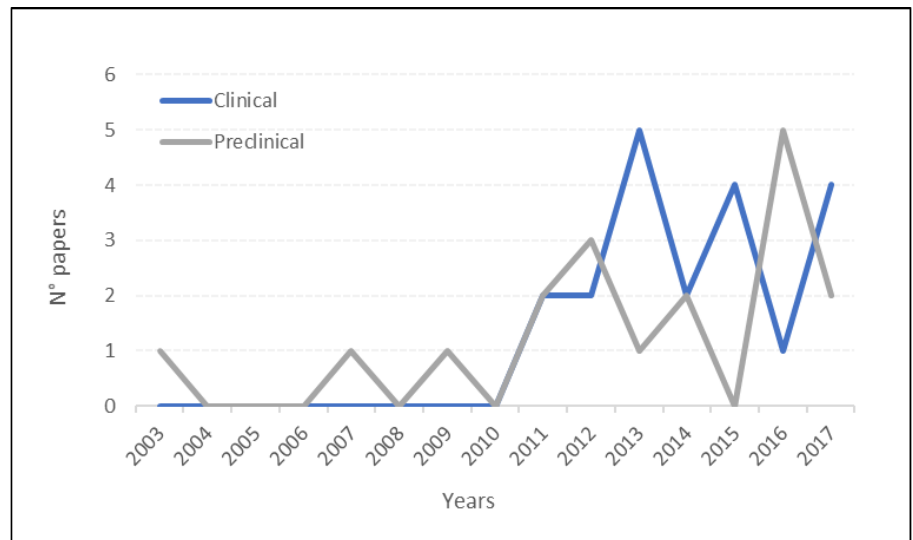
Figure 1. Preclinical and clinical studies published over time.